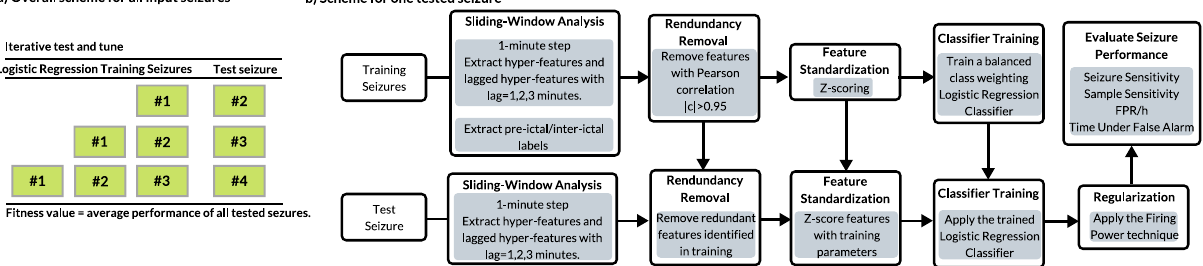
Figure 4. An illustrated scheme of the iterative retraining and testing evaluation ( a ) and the used prediction procedure for one tested seizure ( b